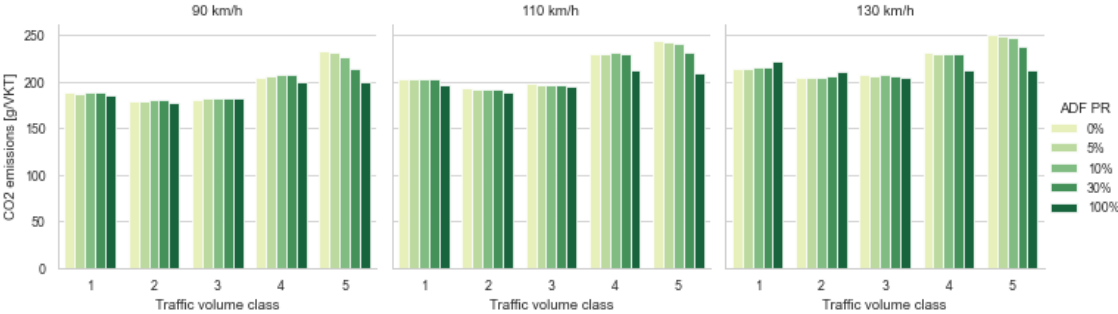
Figure 5. Average CO 2 emissions in grammes per VKT for speed limits of 90, 110 and 130 km/h per traffic volume class and AV penetration rate among passenger cars on EU27+3 motorways. Volume class 1: up to 750 veh/h/lane; 2: 751–1250 veh/h/lane; 3: 1251–1750 veh/h/lane; 4: 1751–2250/ veh/h/lane; 5: over 2250